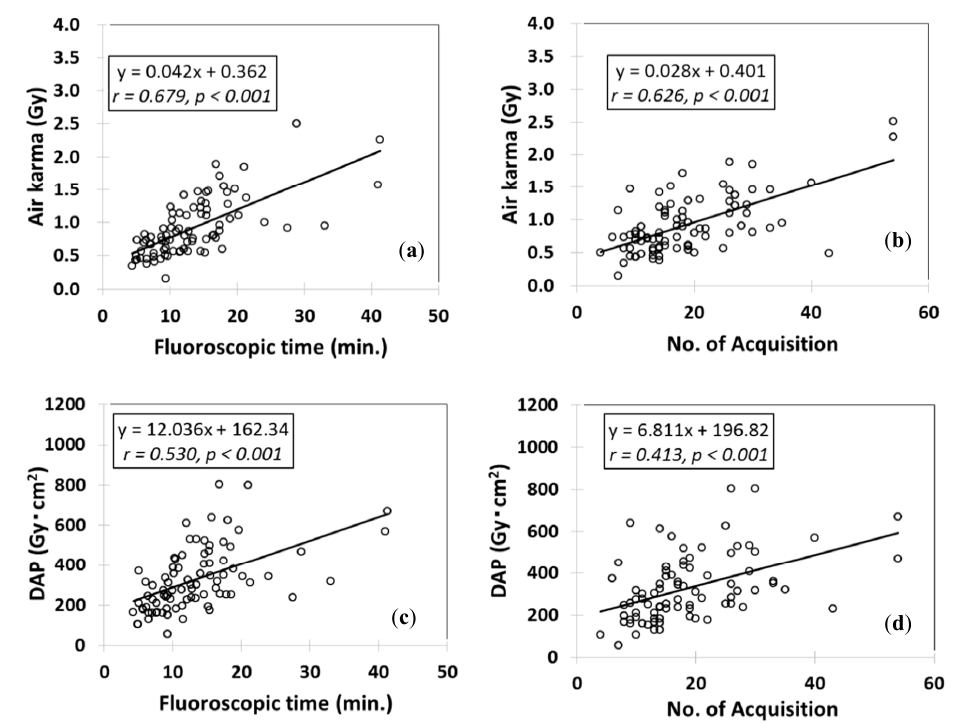
Figure 2. Relationships between the radiation doses during TEVAR and other factors. ( a ) The